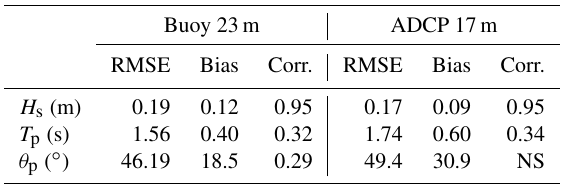
Table 3. Comparison between SWAN results and nearshore wave observations in Playa de Palma. The period spanned by the series is from 1 to 30 September 2015.